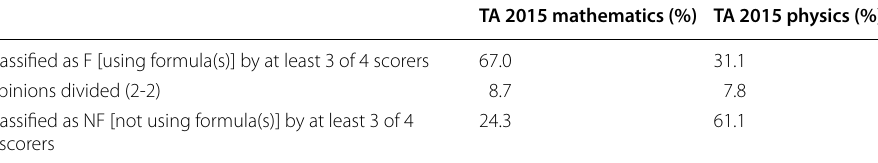
Table 4 Classification of TIMSS Advanced items using the F/NF dichotomy, in percentages of items